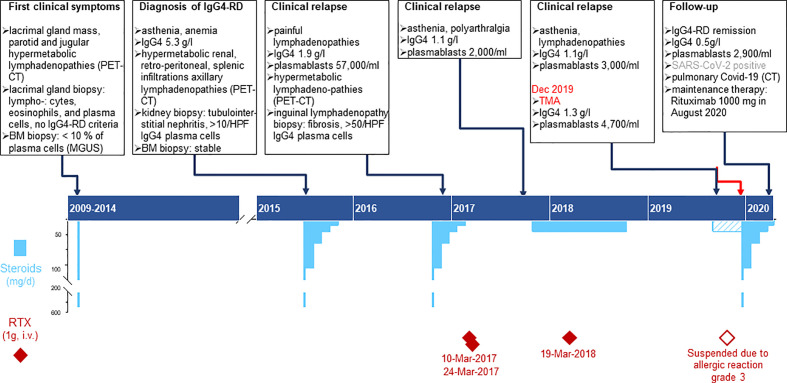
Time course depicting the clinical presentation of IgG4RD, laboratory results and treatment plans from 2009 to 2020. Chronic phase of the patient’s disease: the upper part summarizes the specific features of clinical findings, biopsy, imaging, and immunological laboratory results; the lower part shows the therapy, specifying dose, duration, and dates for Rituximab infusions (deep red diamonds) and steroids (sky blue bars). Pulse treatment with methyl-prednisone (500mg i.v.) is represented by the bottom scale blue bars and was usually followed by oral Prednisone (top scale blue bars); the dashed bar corresponds to the period when the patient did not adhere thoroughly to the prescribed therapy.